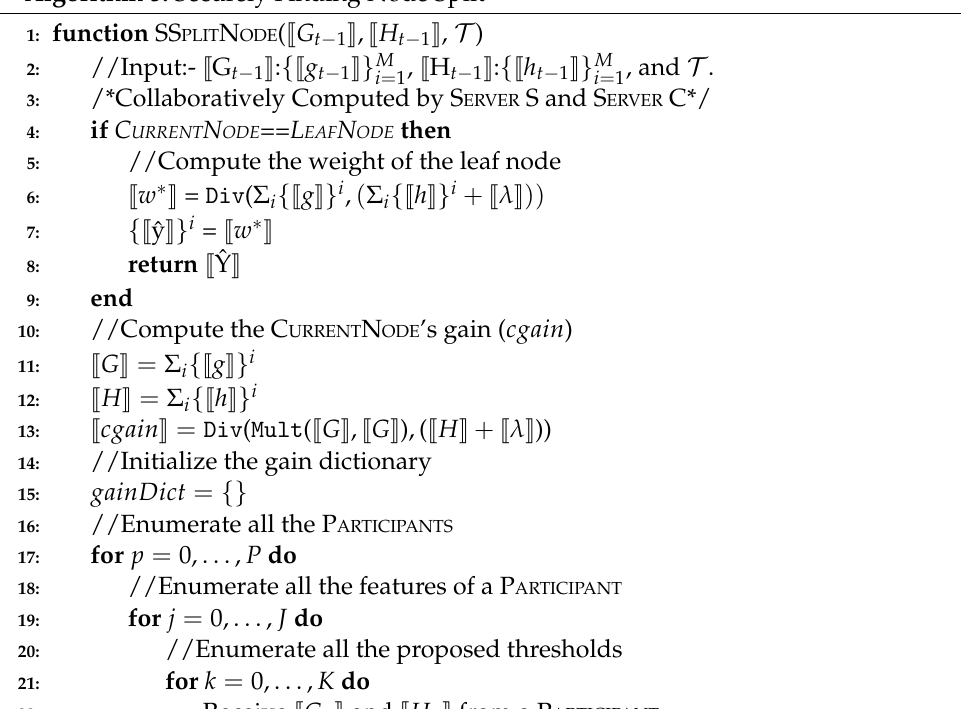
Algorithm 5: Securely Finding Node